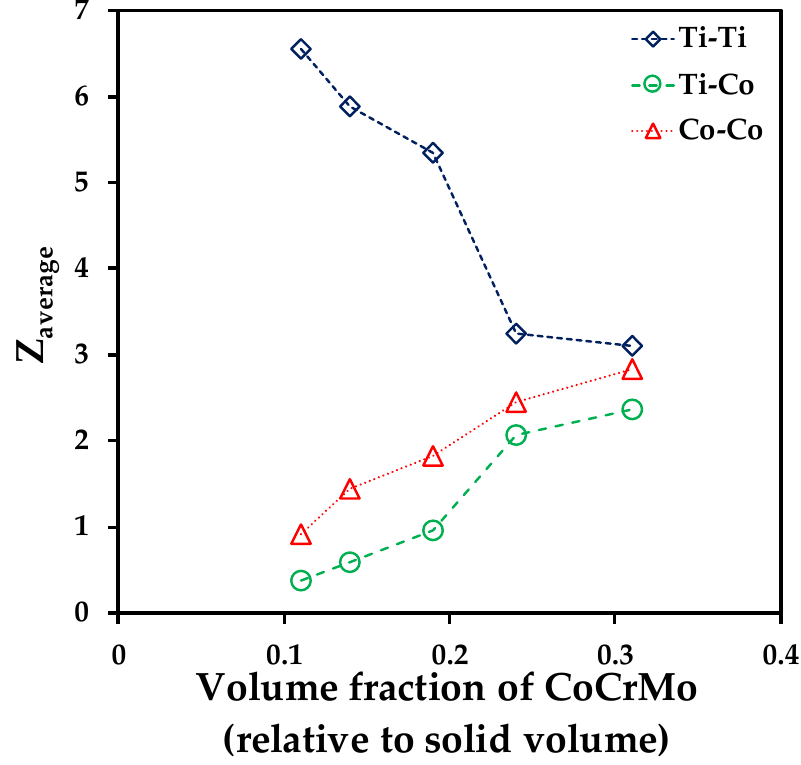
Figure 3. Coordination number of the different kinds of contacts between the powder mixtures as a function of the volume fraction of the CoCrMo particles.